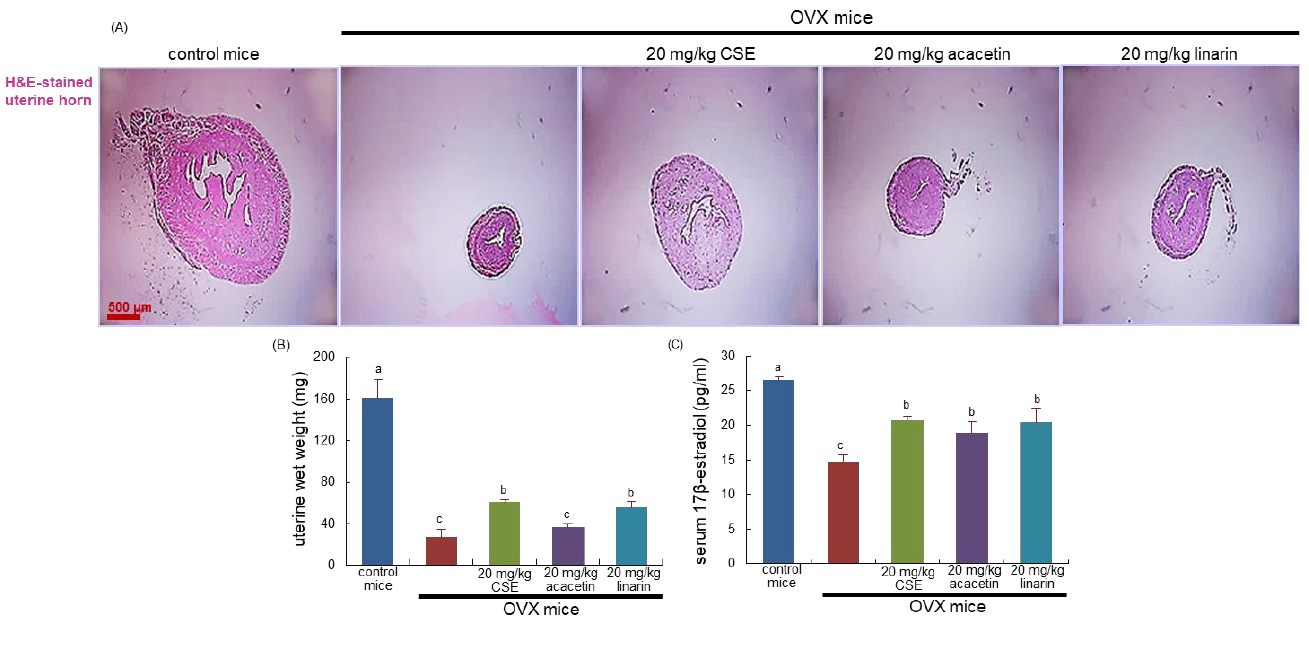
Figure 1. Histological staining of uterus transverse section ( A ), wet weight of uterine tissues ( B ), and serum 17β -estradiol level ( C ) of ovariectomized (OVX) mice orally treated with 20 mg/kg Cirsium setidens water extracts (CSEs), acacetin, or linarin daily for 8 weeks. Cross-sectional images of the uterine horn were obtained by staining with hematoxylin and eosin (H&E) and were visualized using light microscopy. Scale bar = 500 μ m. The serum 17β -estradiol level was determined using an enzyme-linked immunosorbent assay kit. Values in bar graphs (mean ± SEM, n = 9) not sharing a small alphabetical letter are different at p < 0.05.